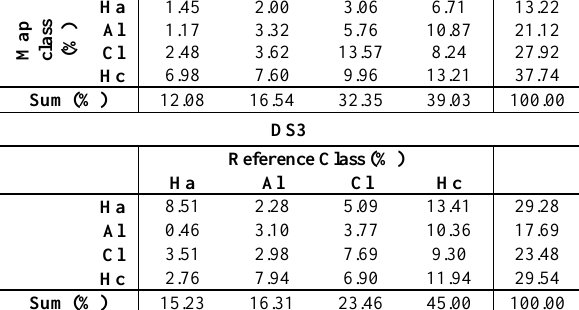
Table 5. Confusion matrix for the data sets classified with SID